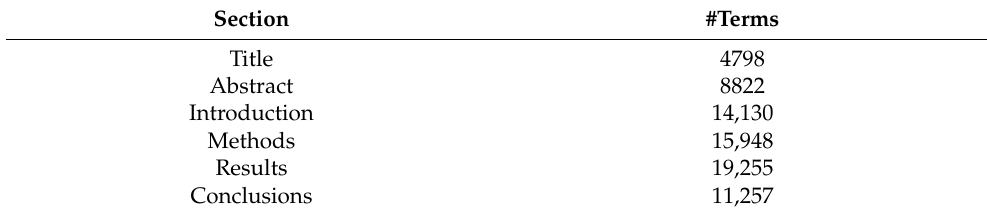
Table 3. Number of terms by section.